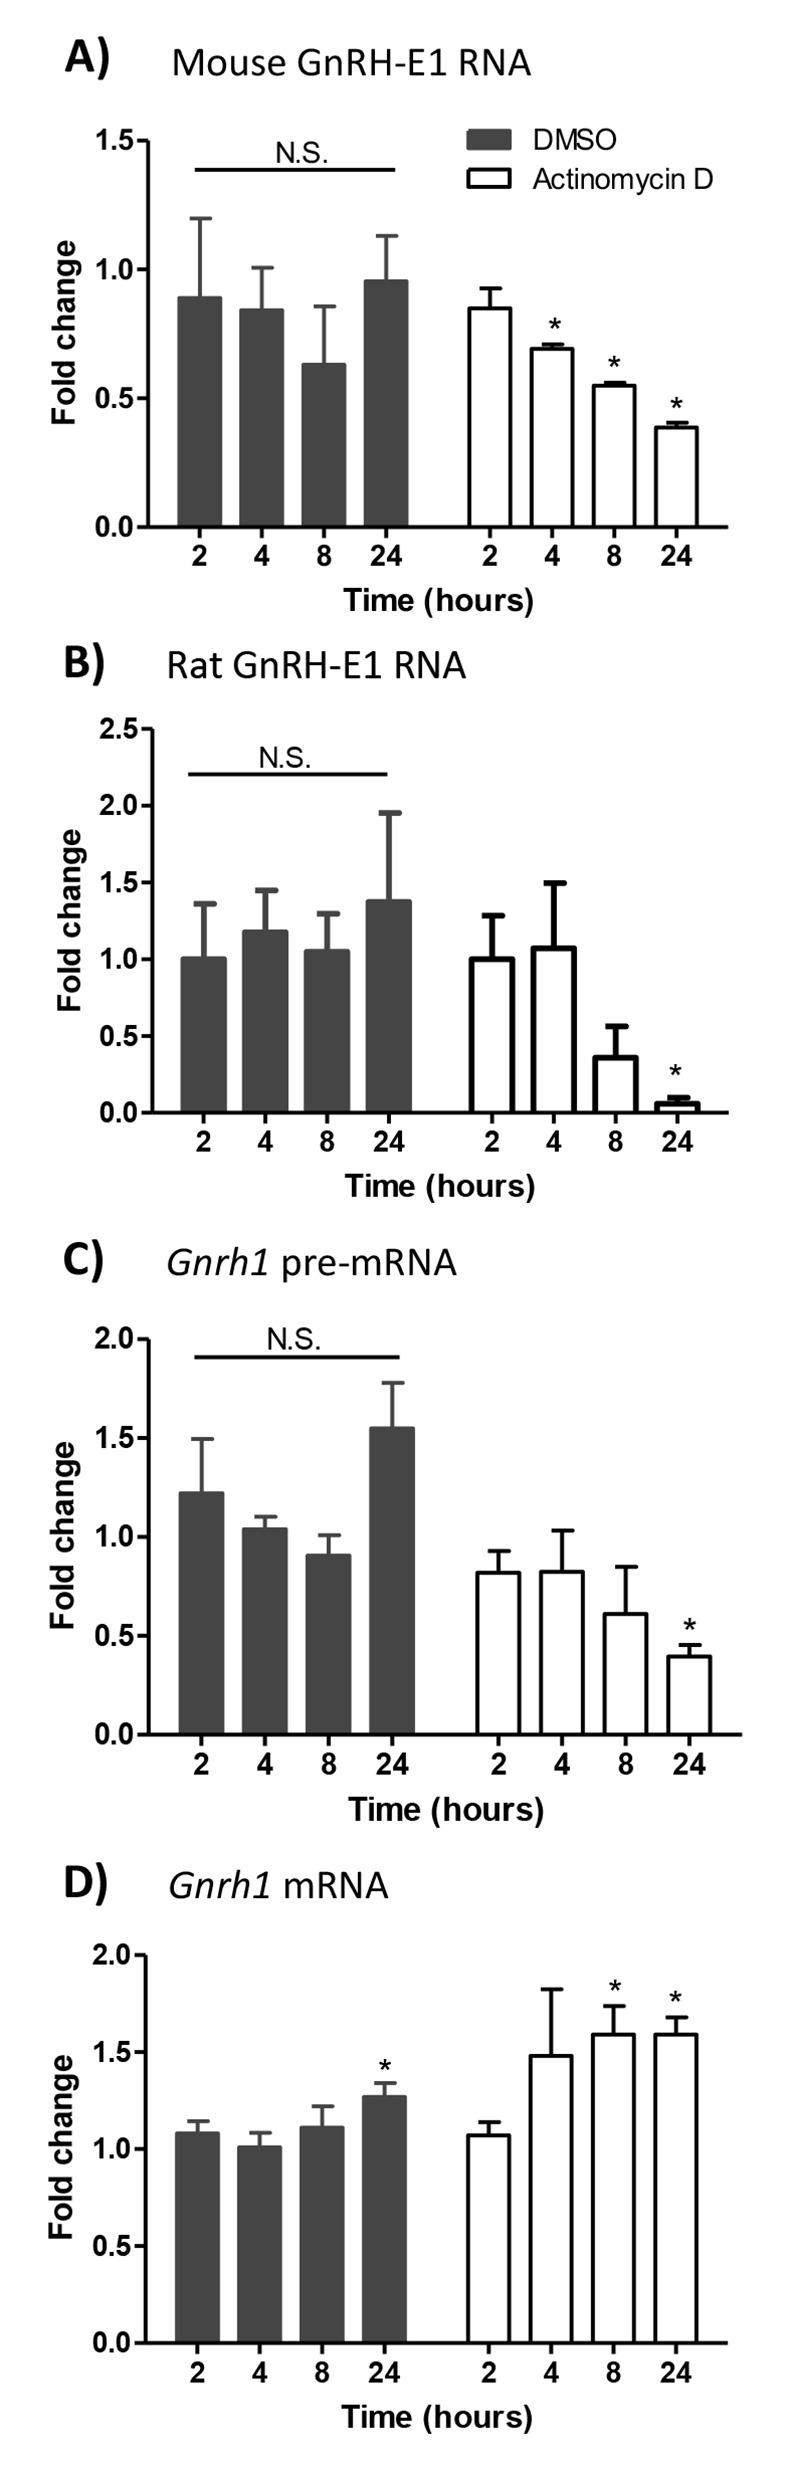
GnRH-E1 RNA, Gnrh1 mRNA, and Gnrh1 pre-mRNA stability following actinomycin D treatment of GT1-7 neurons.GT1-7 neurons were treated with either DMSO control vehicle (black bars) or 1 μg/mL actinomycin D (white bars). Total RNA was harvest at 2, 4, 8, and 24 hours after treatment. RT-qPCR analysis was performed to determine changes in endogenous mouse GnRH-E1 RNA (A), transgene-derived rat GnRH-E1 RNA (B), Gnrh1 pre-mRNA (C) and Gnrh1 mRNA (D) expression. Relative expression is normalized to H2afz mRNA control. Data are displayed as the fold change from untreated cells that were harvested at the time of treatment, and as the mean ± SD. Statistical significance was determined by two-way ANOVA, followed by post hoc Tukey-Kramer HSD, where asterisks indicate statistical significance at p<0.05.